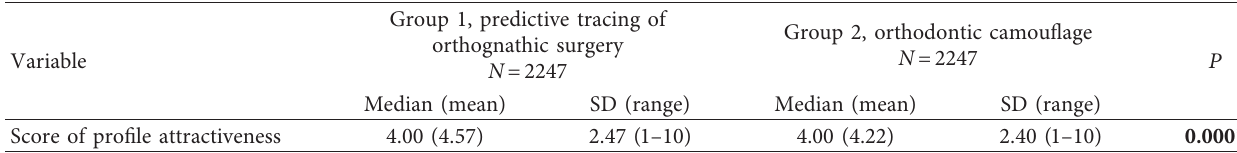
Table 2: Results of comparison of the score of profile attractiveness between predictive tracing of orthognathic surgery and orthodontic camouflage (Mann-Whitey